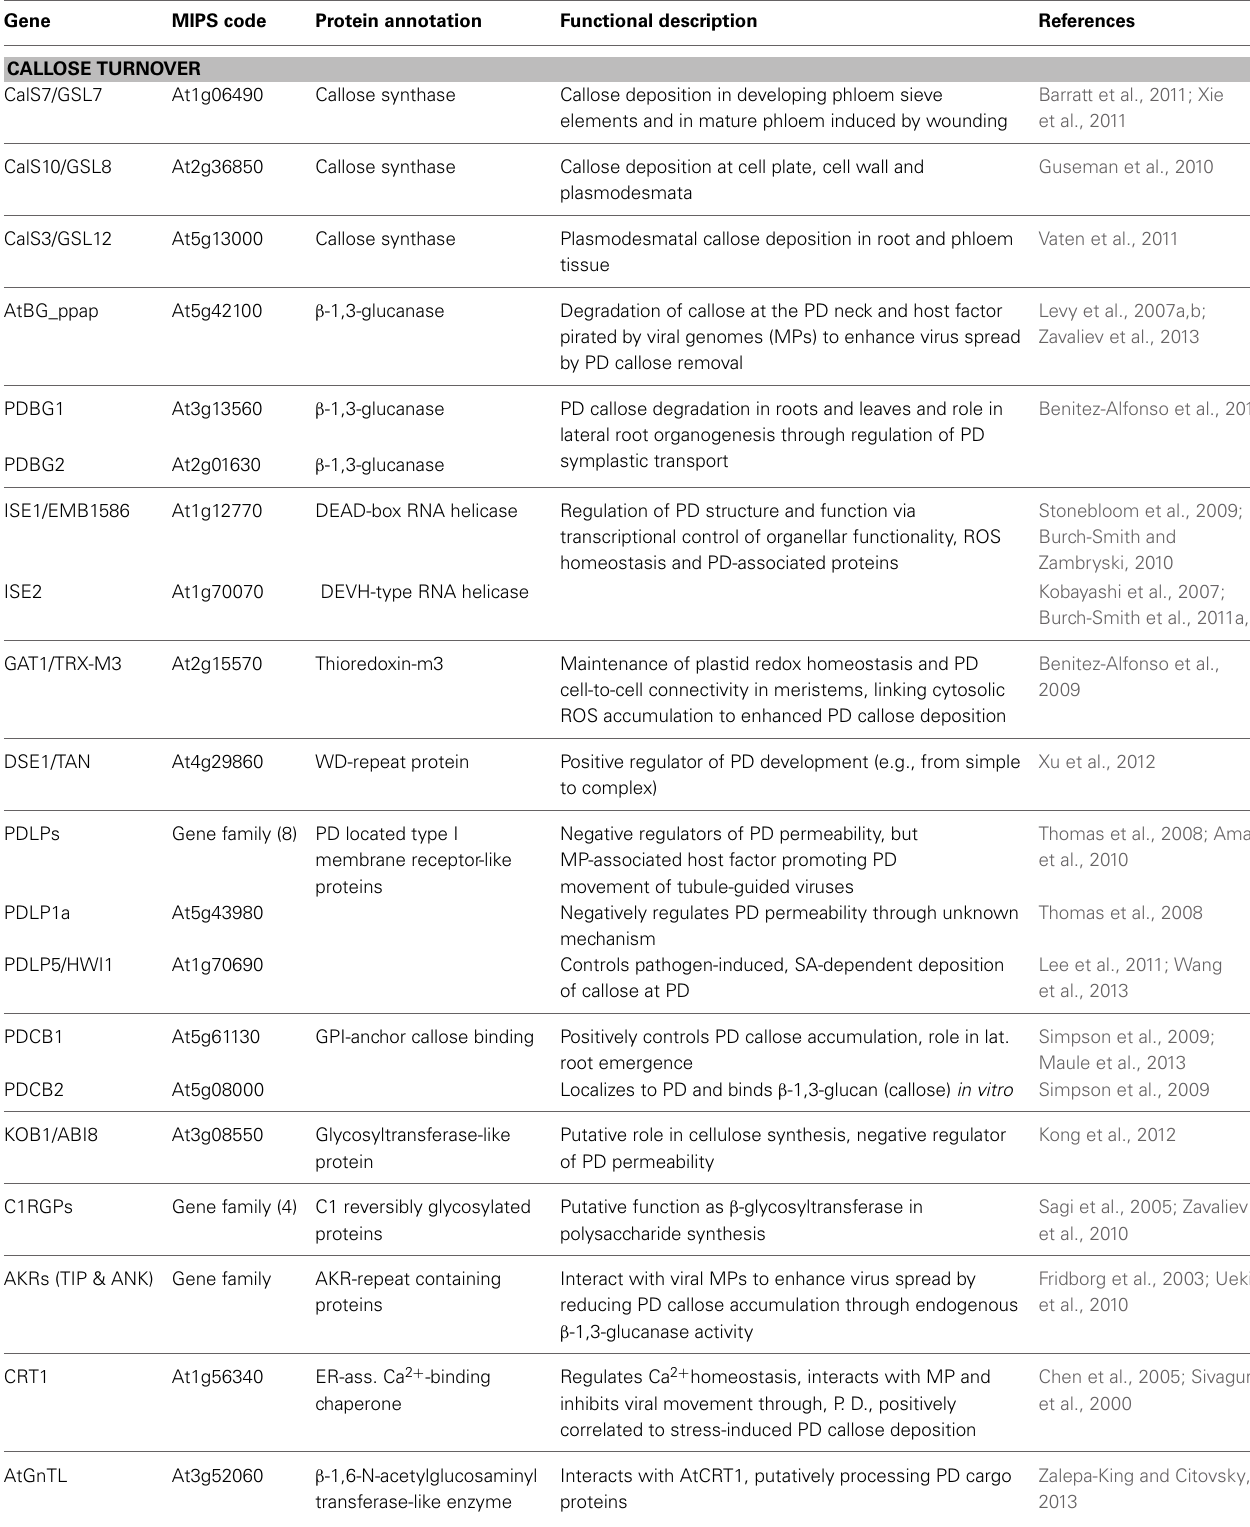
Table 1 | PD callose turnover enzymes and other regulators of PD callose homeostasis.